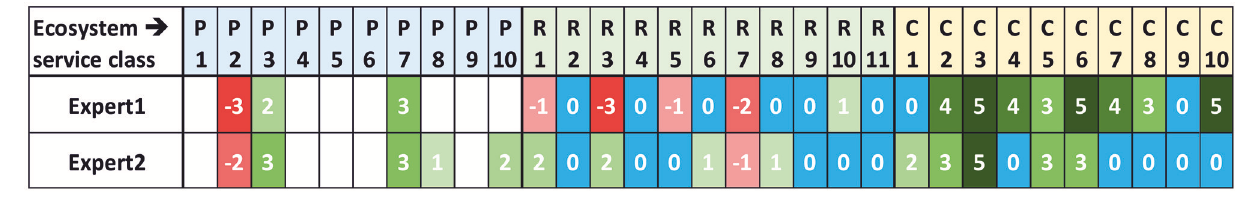
FIGURE 5 | Comparison of the present state of the lagoon with the hypothetical assumption of an implementation of scenario 0, large scale mussel cultivation covering 50% of the lagoon surface. Provisioning (P), regulating and maintenance (R) as well as cultural ES (C). Positive scores indicate an increase in ES provision after the scenario